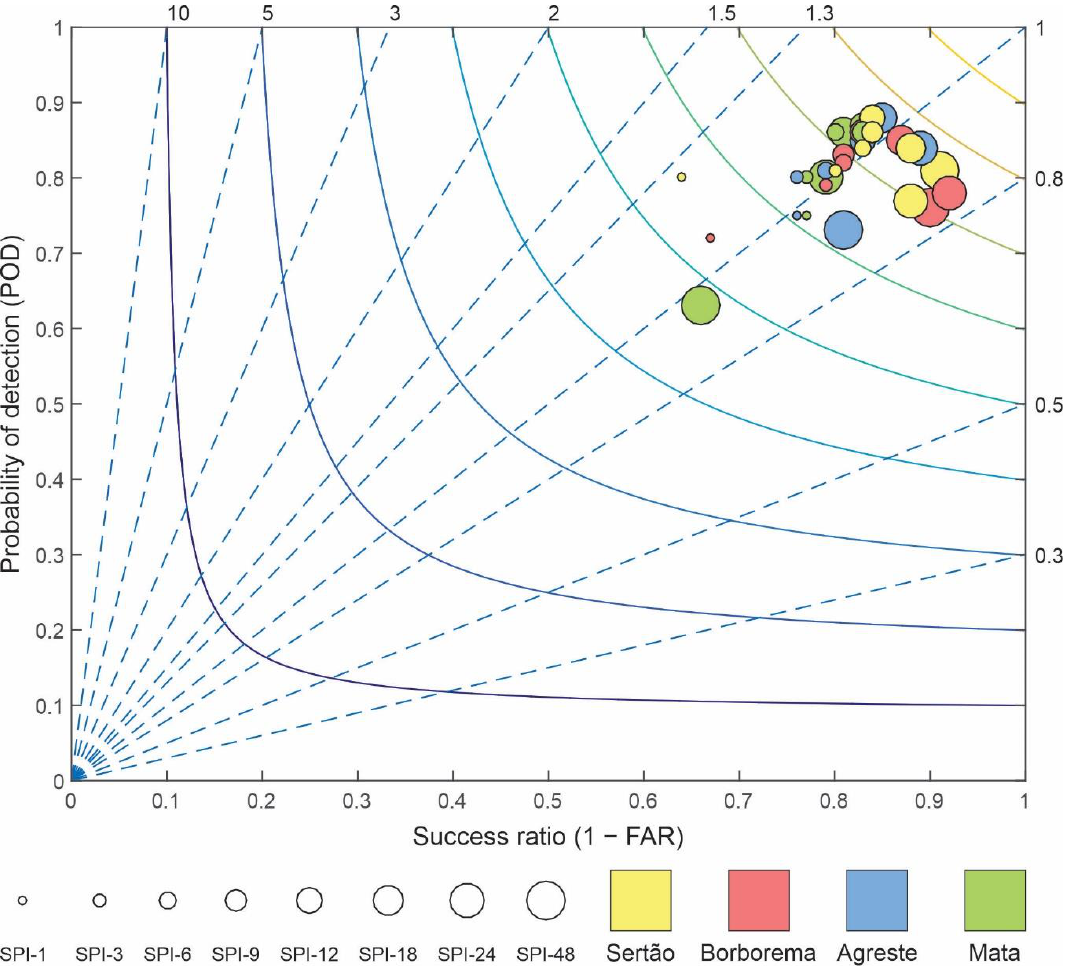
Figure 9. Roebber performance diagram for the Paraíba mesoregions.